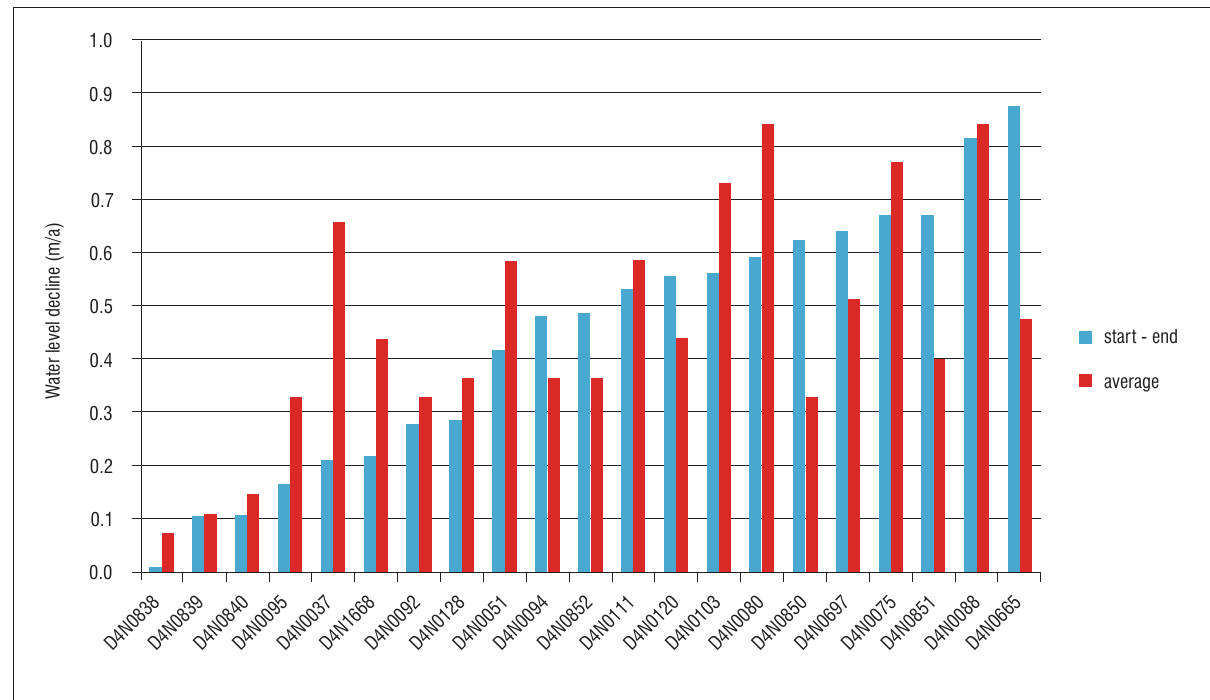
Figure 2: Rates of water level decline for the Grootfontein